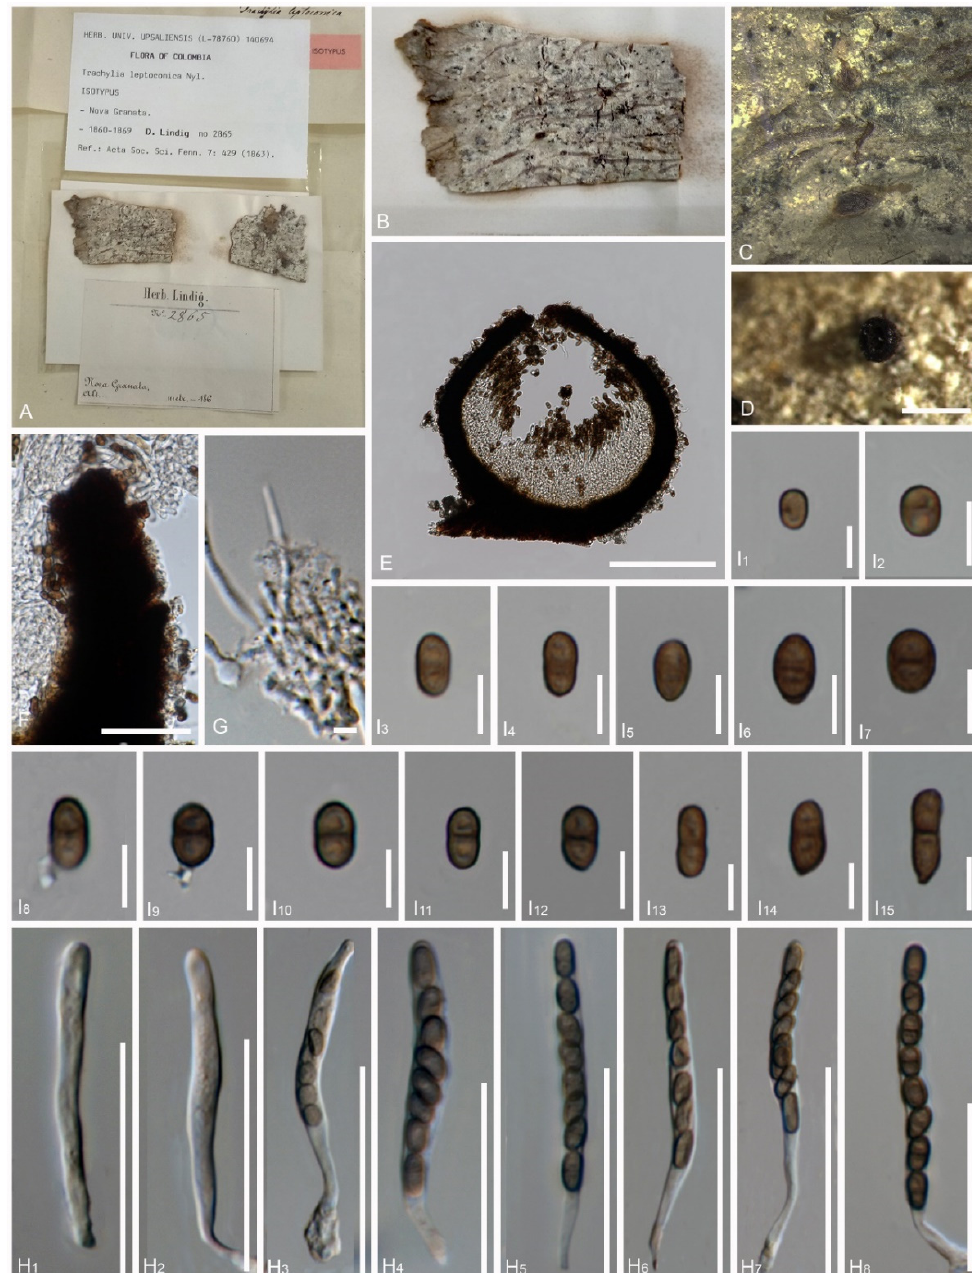
Figure 6. Pyrgidium montellicum (type material of Trachylia leptoconia ) (Lindig 2865, isotype) ( A ). Details of the herbarium specimen, ( B – D ). Ascomata on substrate, ( E ). Vertical section through the